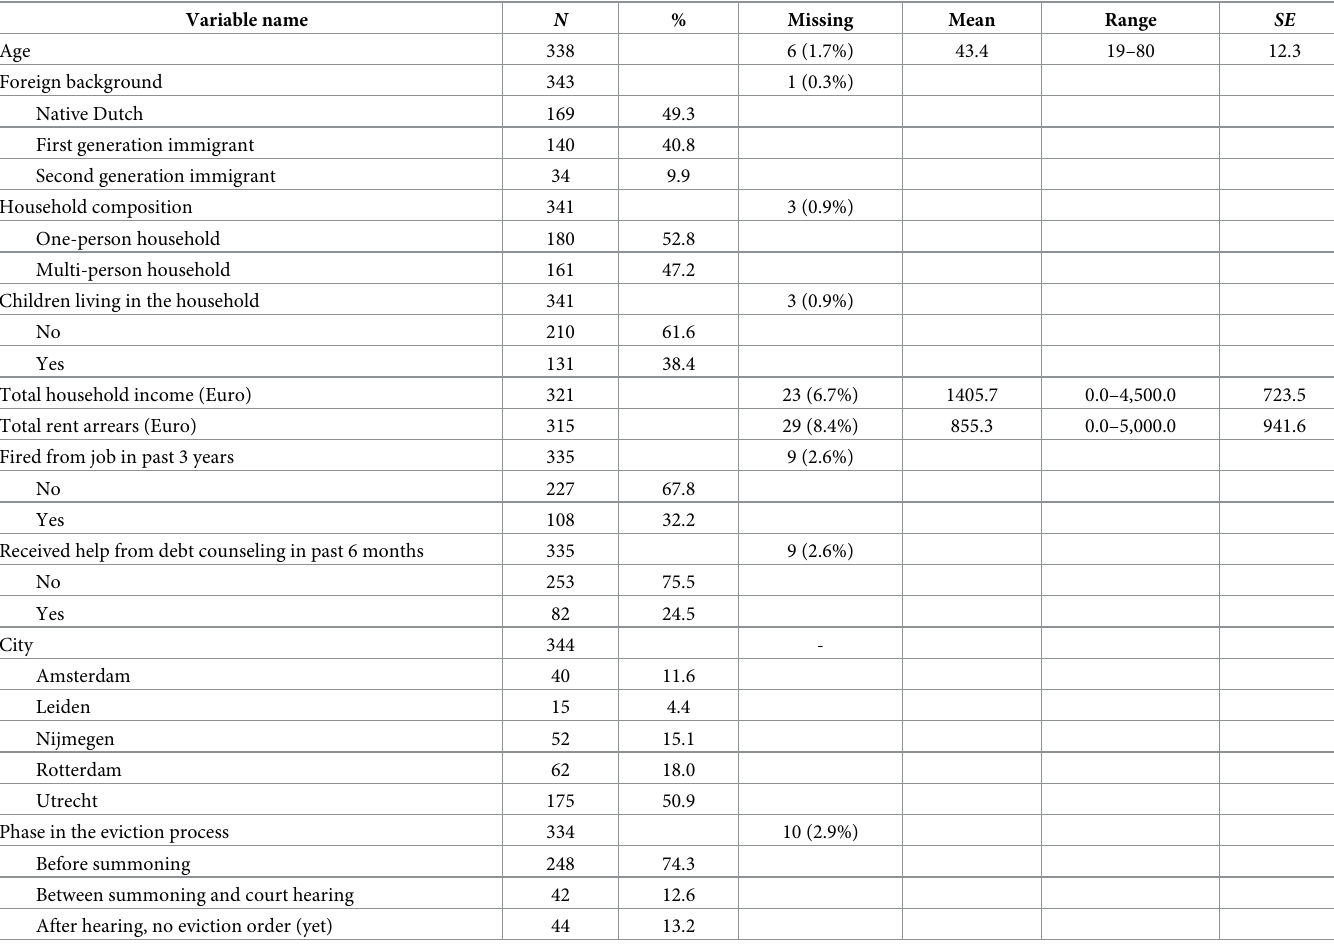
Table 1. Descriptive statistics of predictor variables for available